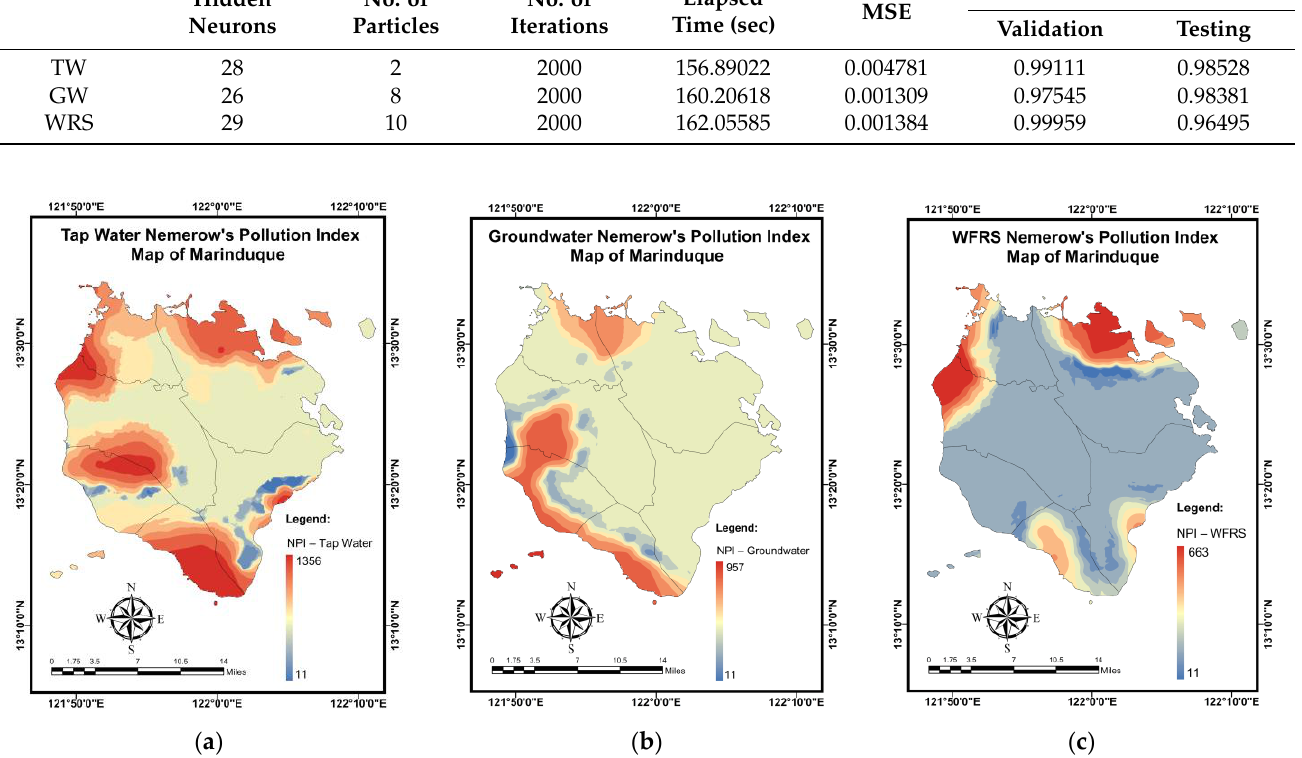
Figure 14. Spatial maps of MPI developed using MLGI approach for ( a ) TW samples, ( b ) GW sam- ples, and ( c ) WRS samples.